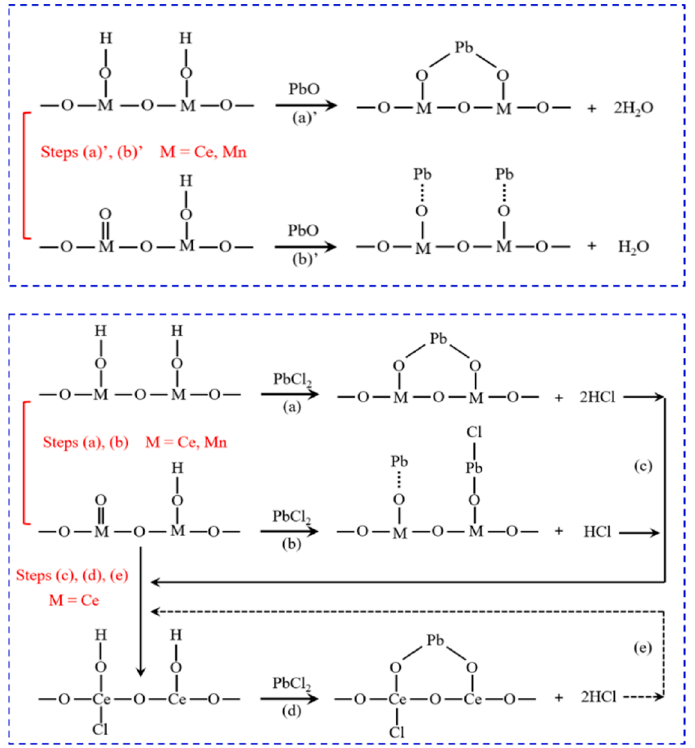
Figure 14. Schematic diagram of PbCl 2 and PbO poisoning mechanisms over MC catalysts [72].